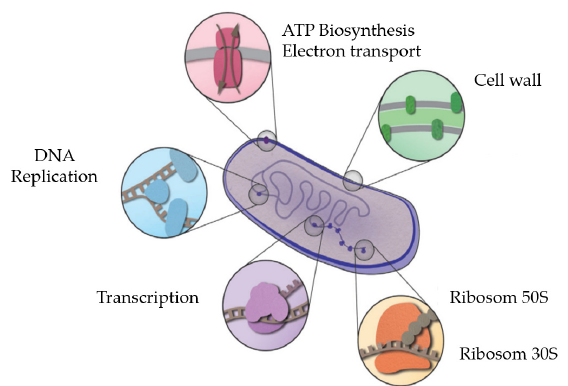
Figure 3. Pathway of inhibition of bacteria by antibacterial agents [73] .